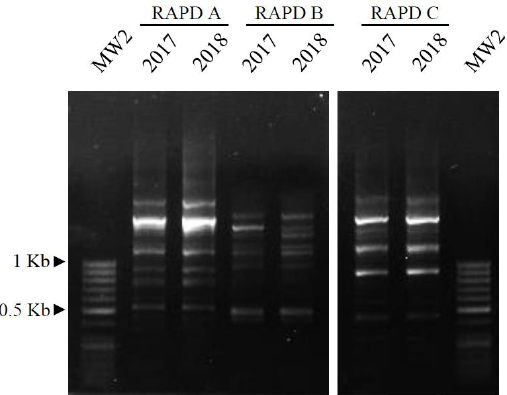
Figure 5. RAPD profiles of the two samples, obtained using three different primer mixes (assays A, B and C), after separation on 1.5% agarose gel and exposure to UV-light. MW2: molecular weight 2, as reported in the Materials and Methods section.